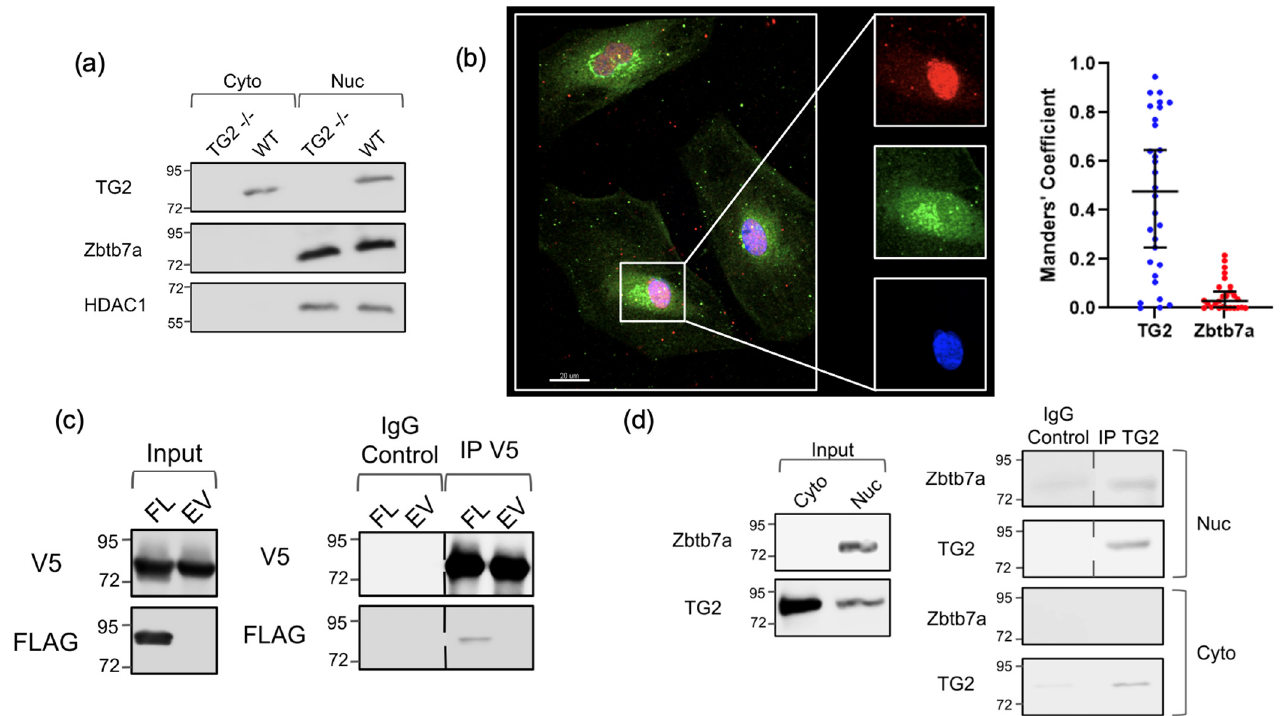
Figure 3. TG2 and Zbtb7a interact. ( a ) Nuclear (Nuc) and cytosolic (Cyto) fractions of wild type (WT) and TG2 knockout (TG2 − / − ) astrocytes. Intensity of bands are not representative of the proportion of the total protein in the cytosolic/nuclear fractions. ( b ) Immunocytochemistry showing co-localization of TG2 (green) and Zbtb7a (red) in nucleus (blue) of astrocytes. Quantification of co-localization of nuclear TG2 and Zbtb7a signal with the median Manders’ coefficient and 95% CI plotted (n = 30 from 2 independent biological replicates). ( c ) Left panel: Input controls of V5-TG2 and FLAG-Zbtb7a (FL) or empty vector (EV) transfected in HEK293TN cells. Right panel: Immunoprecipitation of V5-TG2 (V5) pulls down FLAG-Zbtb7a (FLAG). ( d ) Immunoprecipitation of endogenous TG2 from astrocyte nuclear fraction (nuc) pulls down Zbtb7a. Left panel: input, Right panel: immunoprecipitation with an IgG control or a TG2 antibody. In ( c , d ) vertical dashed lines indicate that intervening lanes were removed.